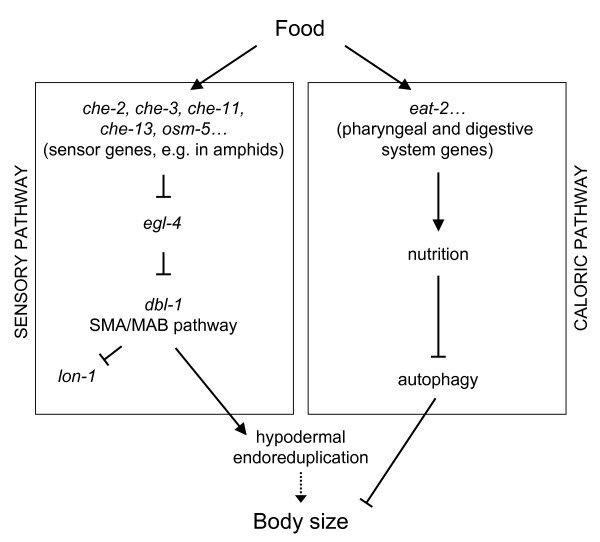
Model of body size regulation by nutrients availability in C. elegans (from L3 onwards). Our results suggest that food availability may regulate body size in at least two ways. First, by the "caloric pathway", that is, simply considering that food intake and its absorption by the digestive tract facilitates nutrition, which in turn may inhibit autophagy. Second, by the "sensory pathway", which refers to the sensing food through organs such as the amphids, with their ciliated neurons expressing genes like che-2, would inhibit EGL-4. Downstream, this cGMP-dependent protein kinase downregulates DBL-1 signalling, which in turn promotes hypodermal endoreduplication, upregulator of body size [36]. LON-1 inhibition by DBL-1 [28] would not influence ploidy upon nutrient activation. This model explains why the nutrient-dependent regulation that the sensory cilia proteins, EGL-4 and DBL-1 are all playing on hypodermal polyploidization has not been observed for body size; their role on body size, but not upon endoreduplication, may be obscured by the dominant influence of caloric restriction.